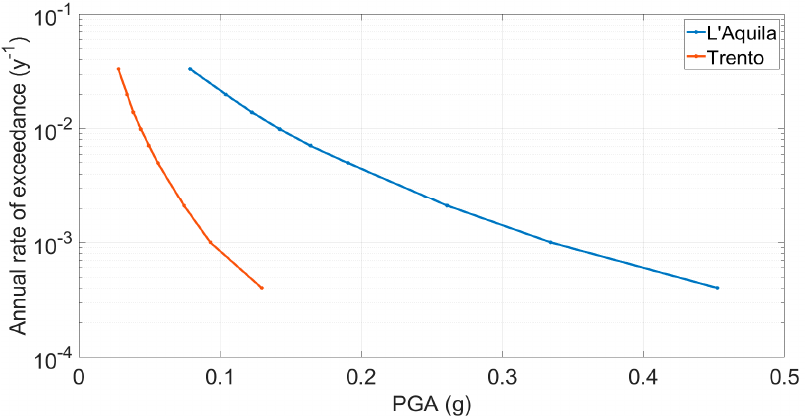
Figure 5. Seismic hazard curves of L’Aquila and Trento, Italy. PGA, peak ground acceleration. Table 2. Seismic fragility function parameters.